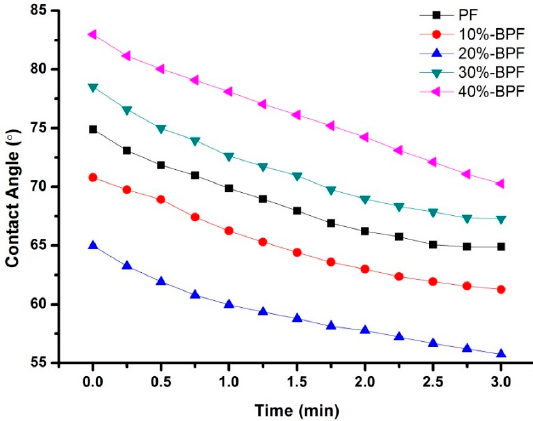
Figure 4. Contact angle curves of various BPF resins and GF.